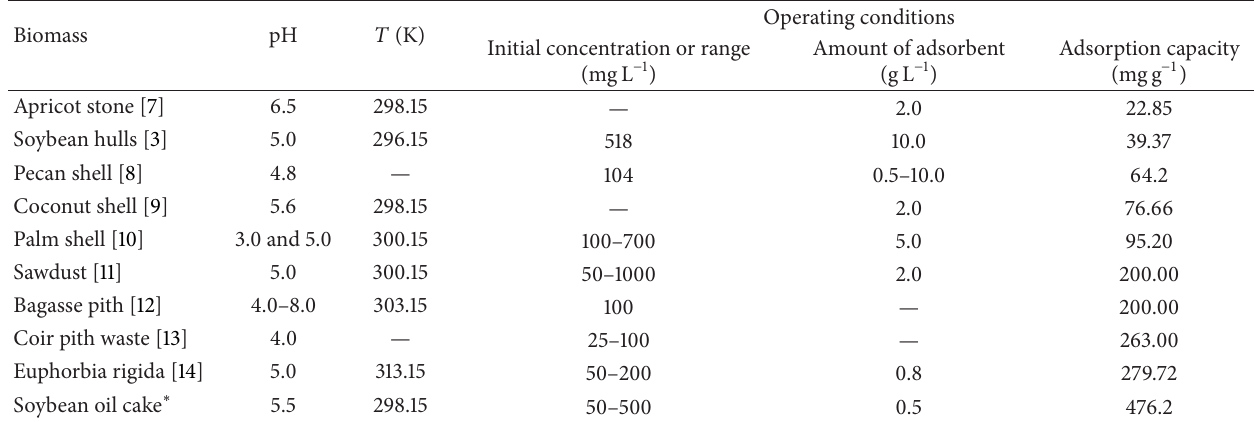
Table 4: Comparison of adsorption capacities of activated carbons obtained from various lignocellulosic materials for lead (II) ions.